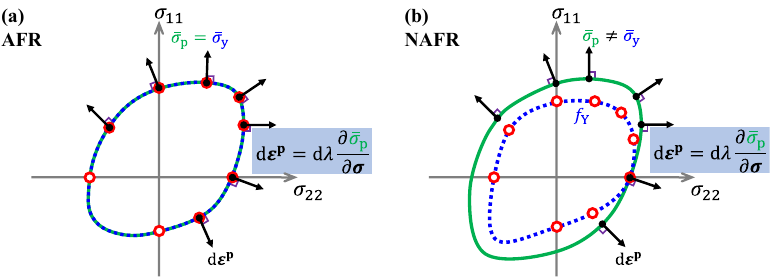
Figure 9. Constitutive model of plastic deformation under ( a ) AFR and ( b ) NAFR.